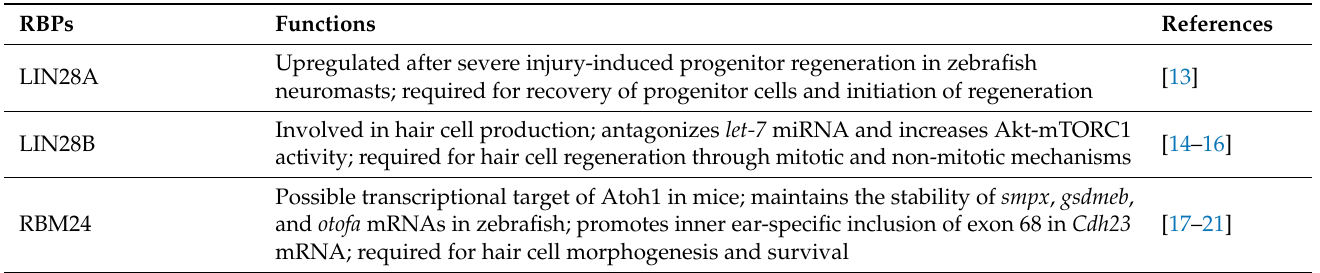
Table 1. RBPs in inner ear hair cell development, regeneration, and